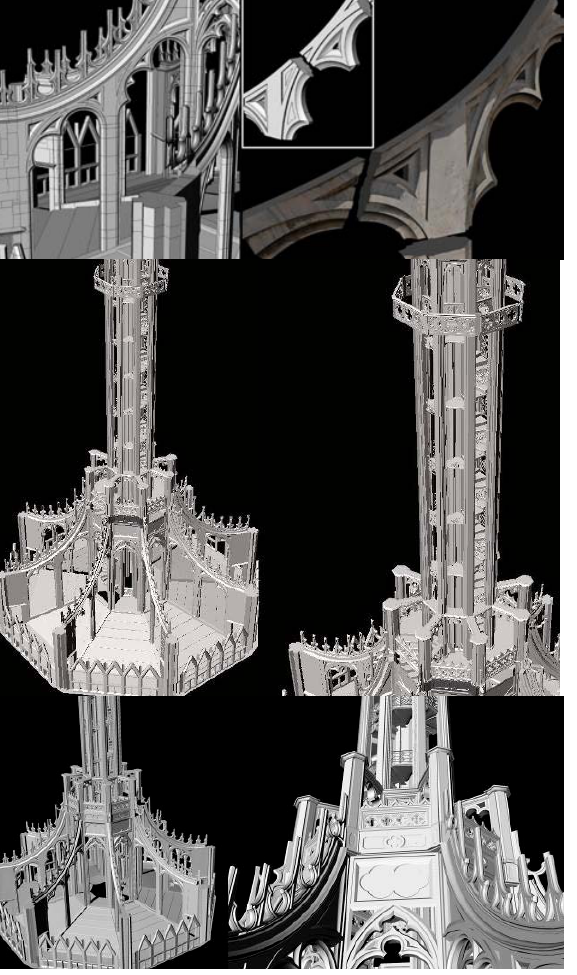
Figure 12: At the end of the modeling phase the global model is made up of six macro-blocks subdivided into micro-bocks corresponding to the clearly identifiable and/or decorative building parts. Each of these, is in turn composed of its elementary constructive